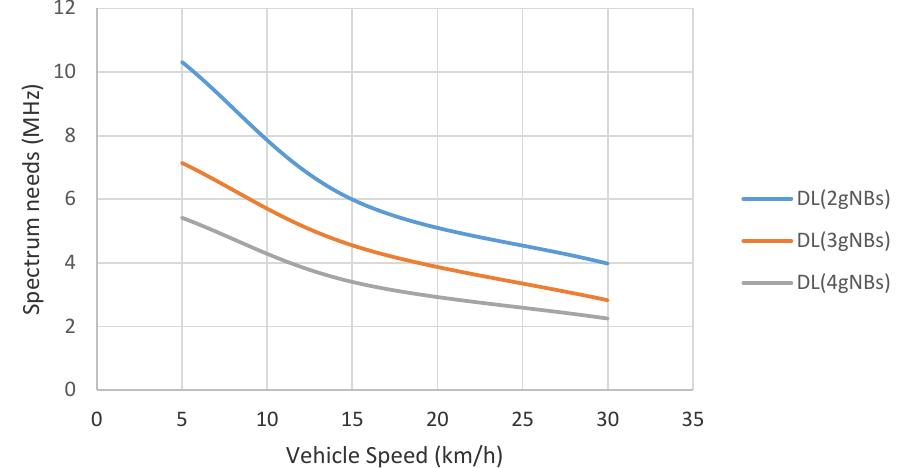
Figure 4. Downlink (DL) spectrum needs per gNB sector in the urban grid environment.